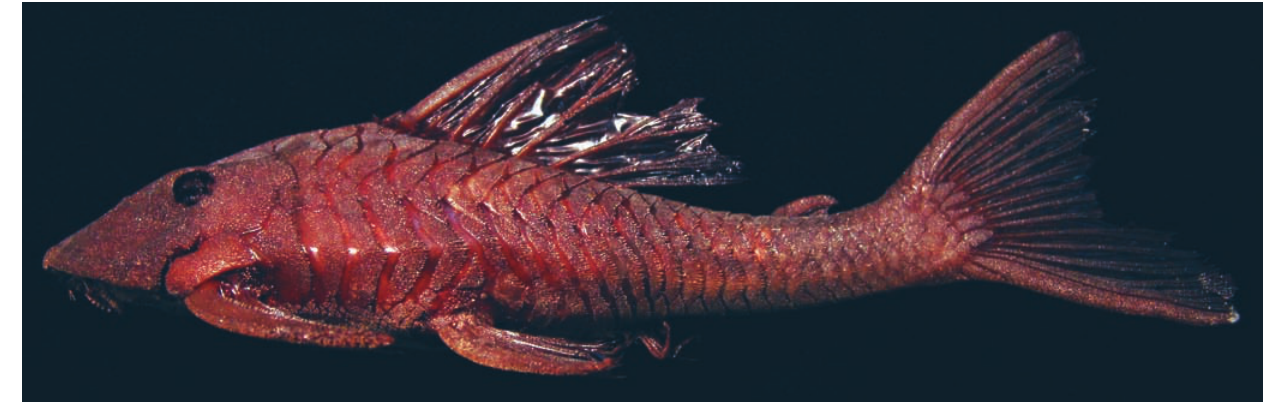
Fig. 1. Hypostomus cochliodon , lectotype, NMW 44101, 182.5 mm SL, rio Cuiabá, in lateral